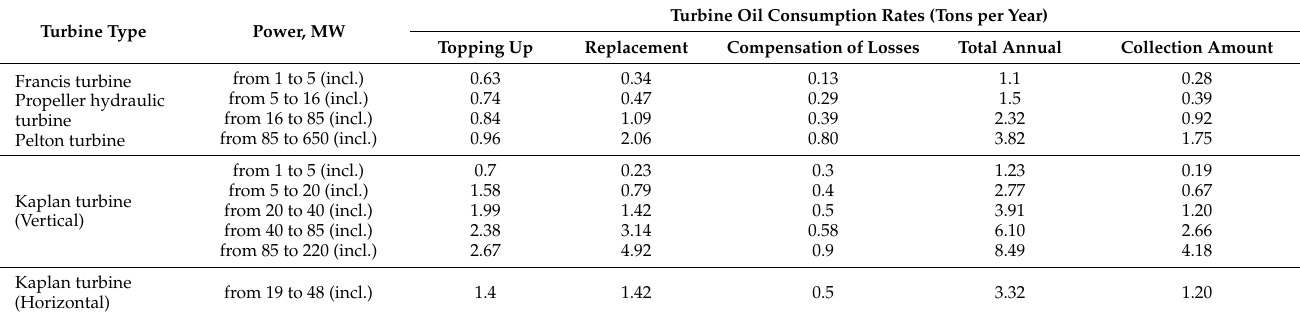
Table 2. Oil consumption in hydropower units [11].